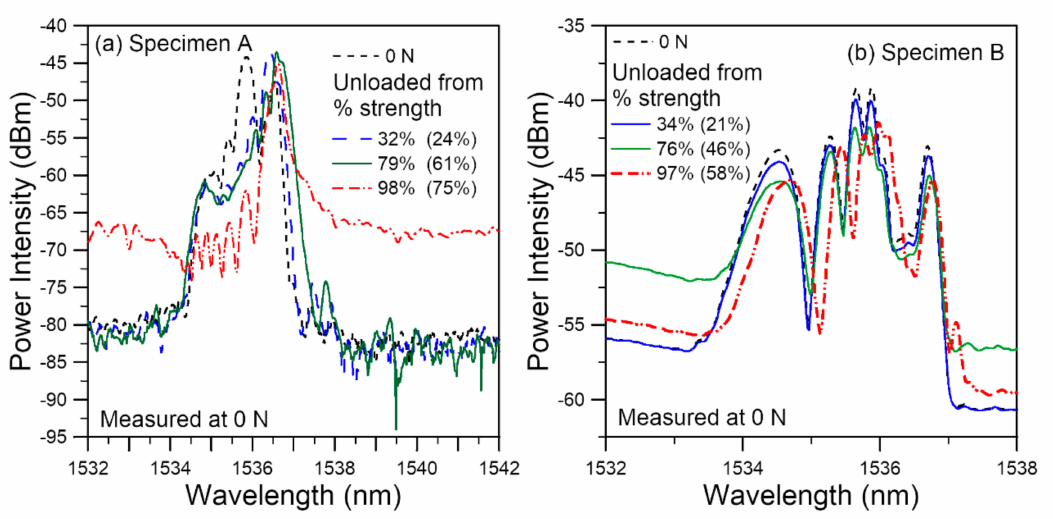
Figure 11. FBG spectra of hygrothermally treated specimens measured at 0 N after unloading from various tensile loads shown as a percentage of the current specimen strength as well as a percentage of the average virgin batch strength (bracketed numbers) from ( a ) specimen A and ( b ) specimen